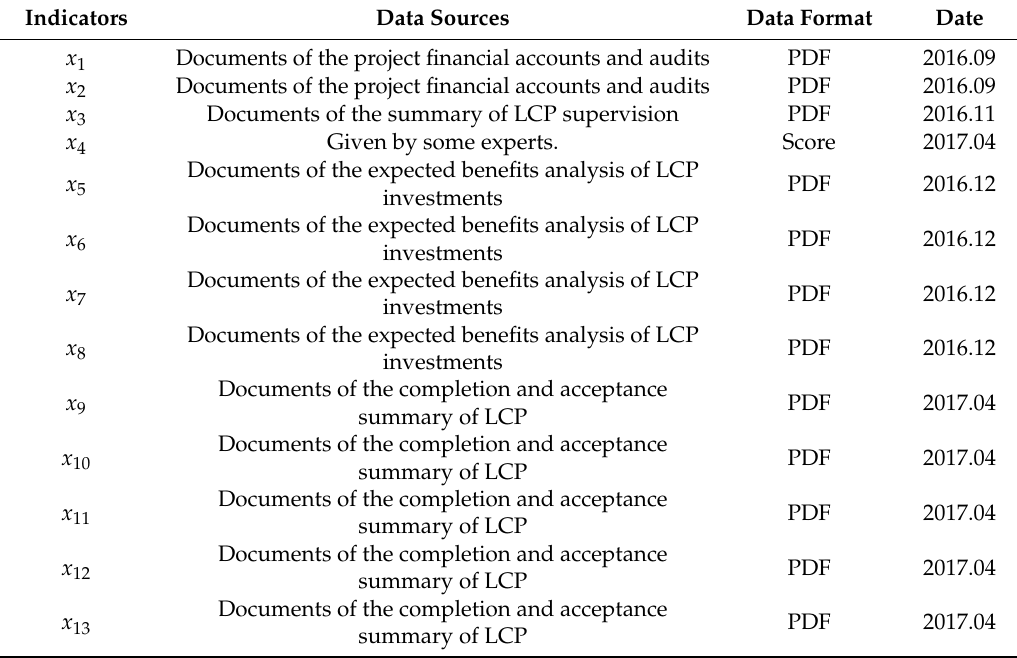
Table 3. Data sources for the indicators in this paper.